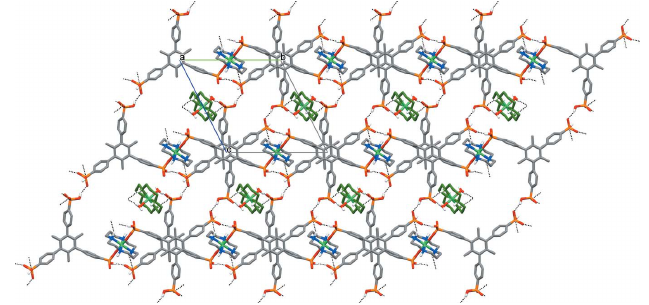
Figure 2 The hydrogen-bonded (dashed lines) layers in I viewed down the a axis. C-bound H atoms and macrocyclic cations formed by Ni3 have been omitted; C and N atoms of the macrocyclic cations formed by Ni2 are shown in green.